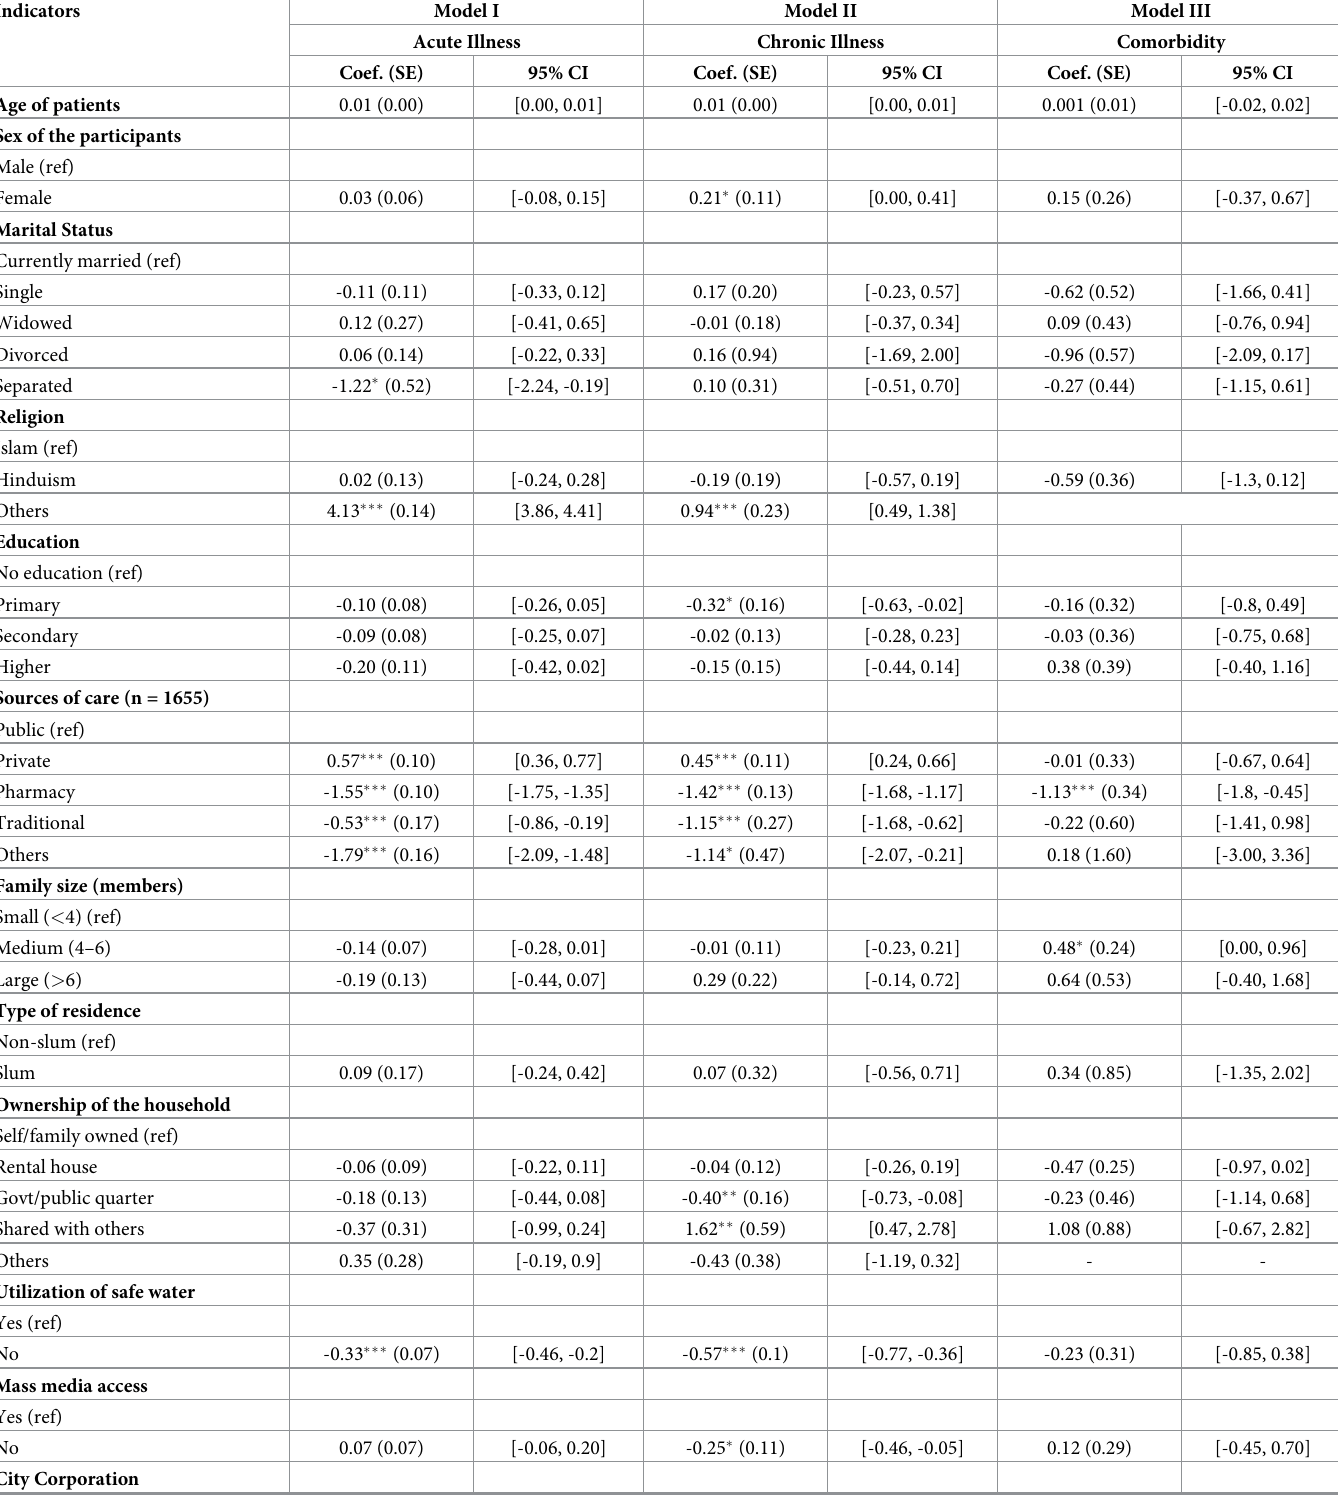
Table 5. Factors associated with OOPE across socioeconomic